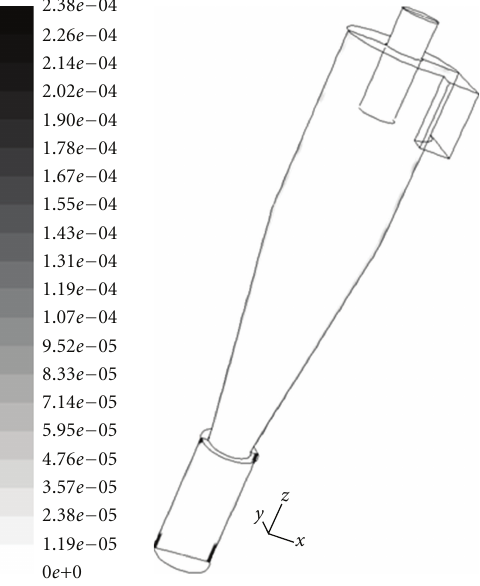
monodispersed particles leads to a di ff erent particles be- havior and hence di ff erent e ff ect on the gaseous phase. Qian et al. [19] attempted to take into account the size distribution in their simulation work, using the granular mixture model, by creating several solid phases with di ff erent average size.